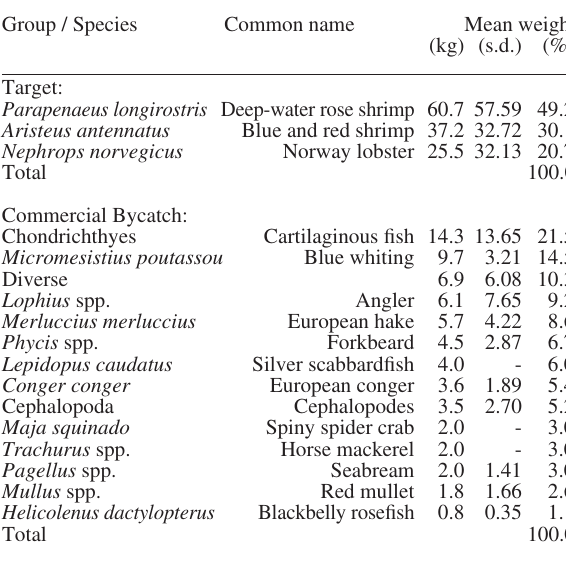
Table 2. – target and commercial bycatch species caught by crus- Table 3. – target and commercial bycatch species caught by tacean trawl off southern Portugal from 1999 to 2001(per tow) fish trawl off southern Portugal from 1999 to 2001(per tow) (s.d.=standard deviation). (s.d.=standard